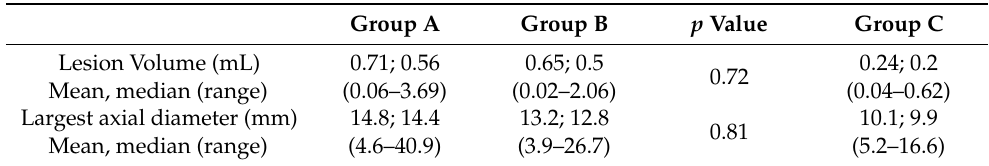
Table 3. Mean, median value, and range of volume and largest axial diameter of lesions in groups A, B, and C, according to the Quantib